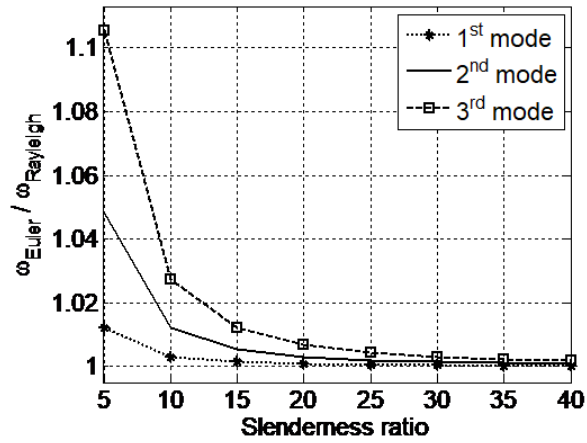
Figure 3: Variation of the non-classical frequency ratio against slen- derness ratio and mode